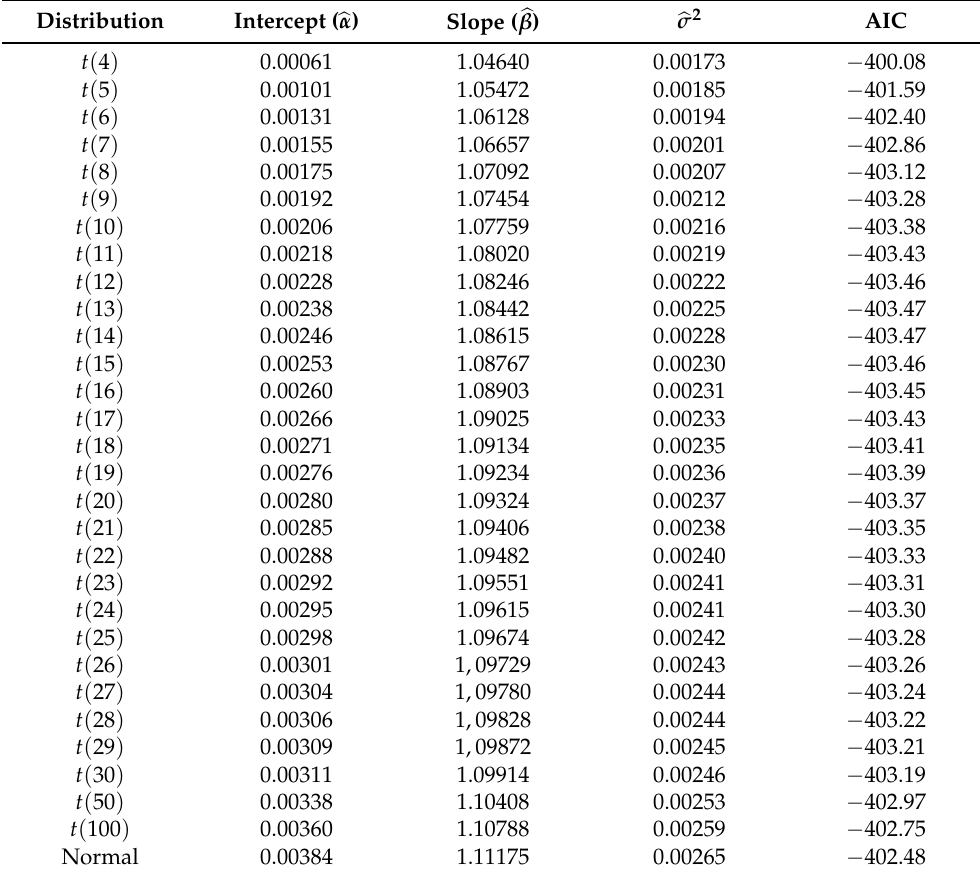
Table 5. CAPM fit under the Student-t distribution with data of monthly returns.